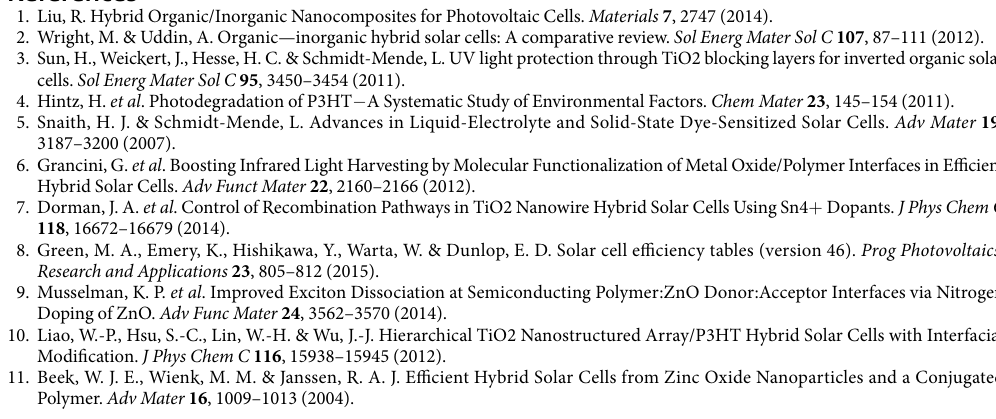
6 SCientifiC REPORTS | (2018) 8:3559 | DOI:10.1038/s41598-018-21721-2